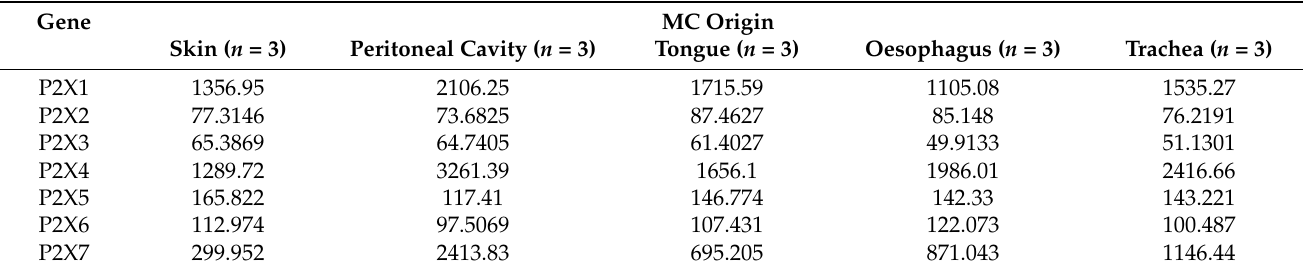
Table 2. P2XR expression in mouse MCs of different tissue origin. Shown are robust multichip average (RMA) normalized values. Data were obtained from the ImmGen consortium